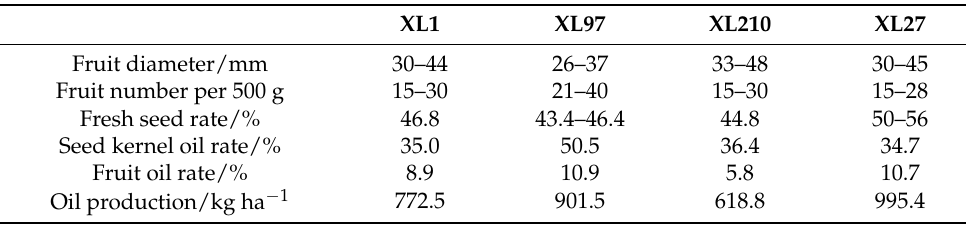
Table 1. Characters and yield performances of various cultivars of C. oleifera